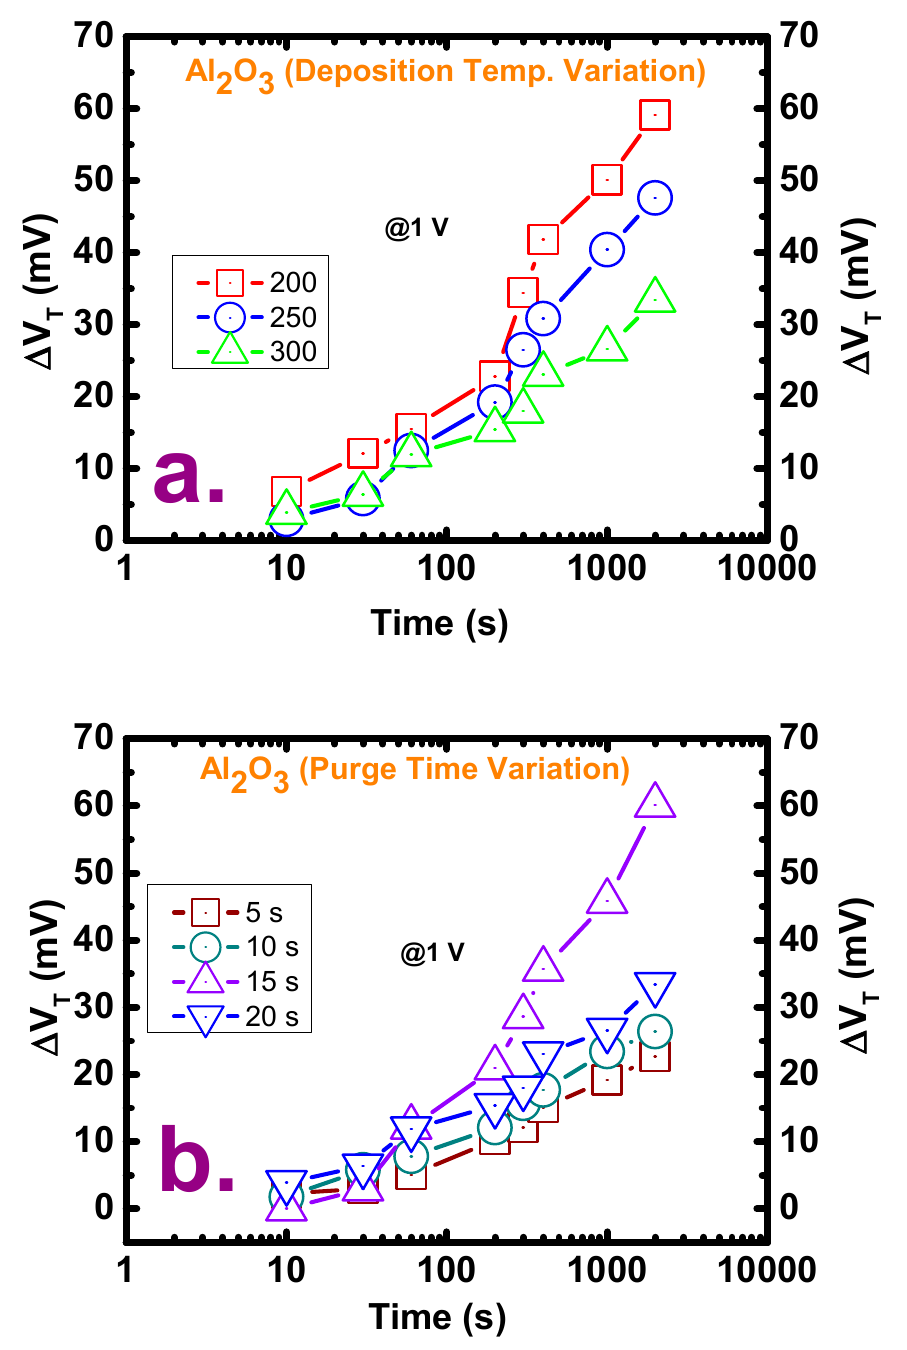
Figure 5. Threshold voltage shift ( V TH ) after the application of constant voltage stress (CVS) at a bias of 1 V for films ( a ) deposited at three temperatures (200, 250, and 300 °C) with a purge time of 20 s and ( b ) deposited with four purge times (5, 10, 15, and 20 s) at a deposition temperature of 250 °C.